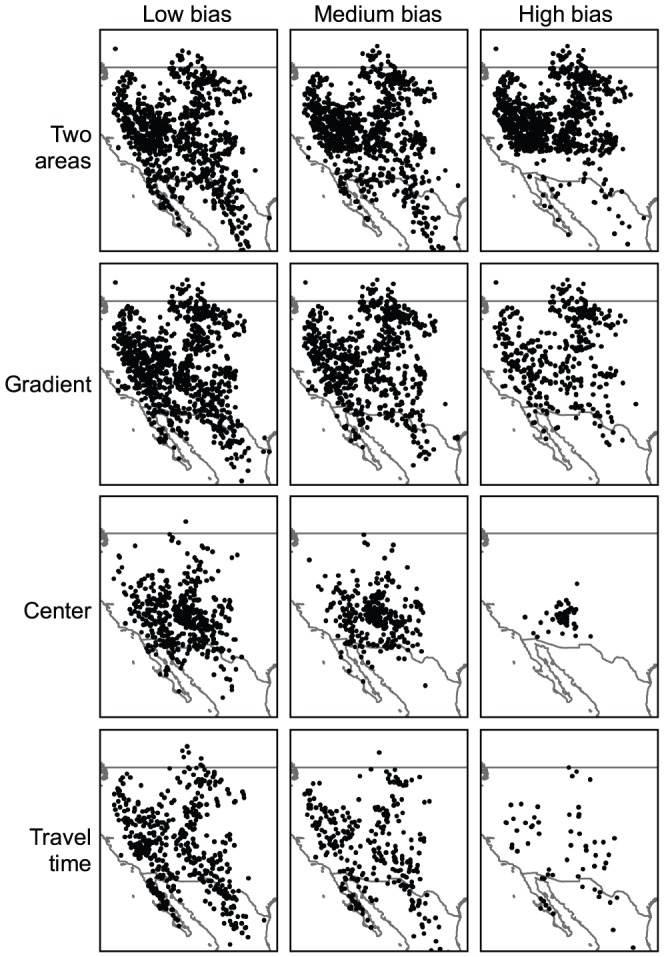
Generation of sampling bias for the virtual species.To generate artificial sampling bias, the original dataset (here the virtual species) was altered into 4 different types of bias (rows), each with 3 intensities (columns).